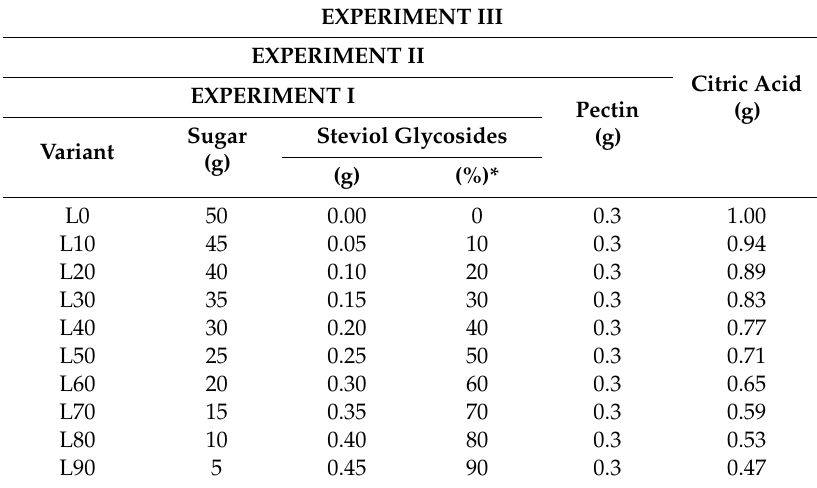
Table 1. The composition of evaluated low-sugar (L) apple preserves in 3 stages of experiments for 100 g of apple